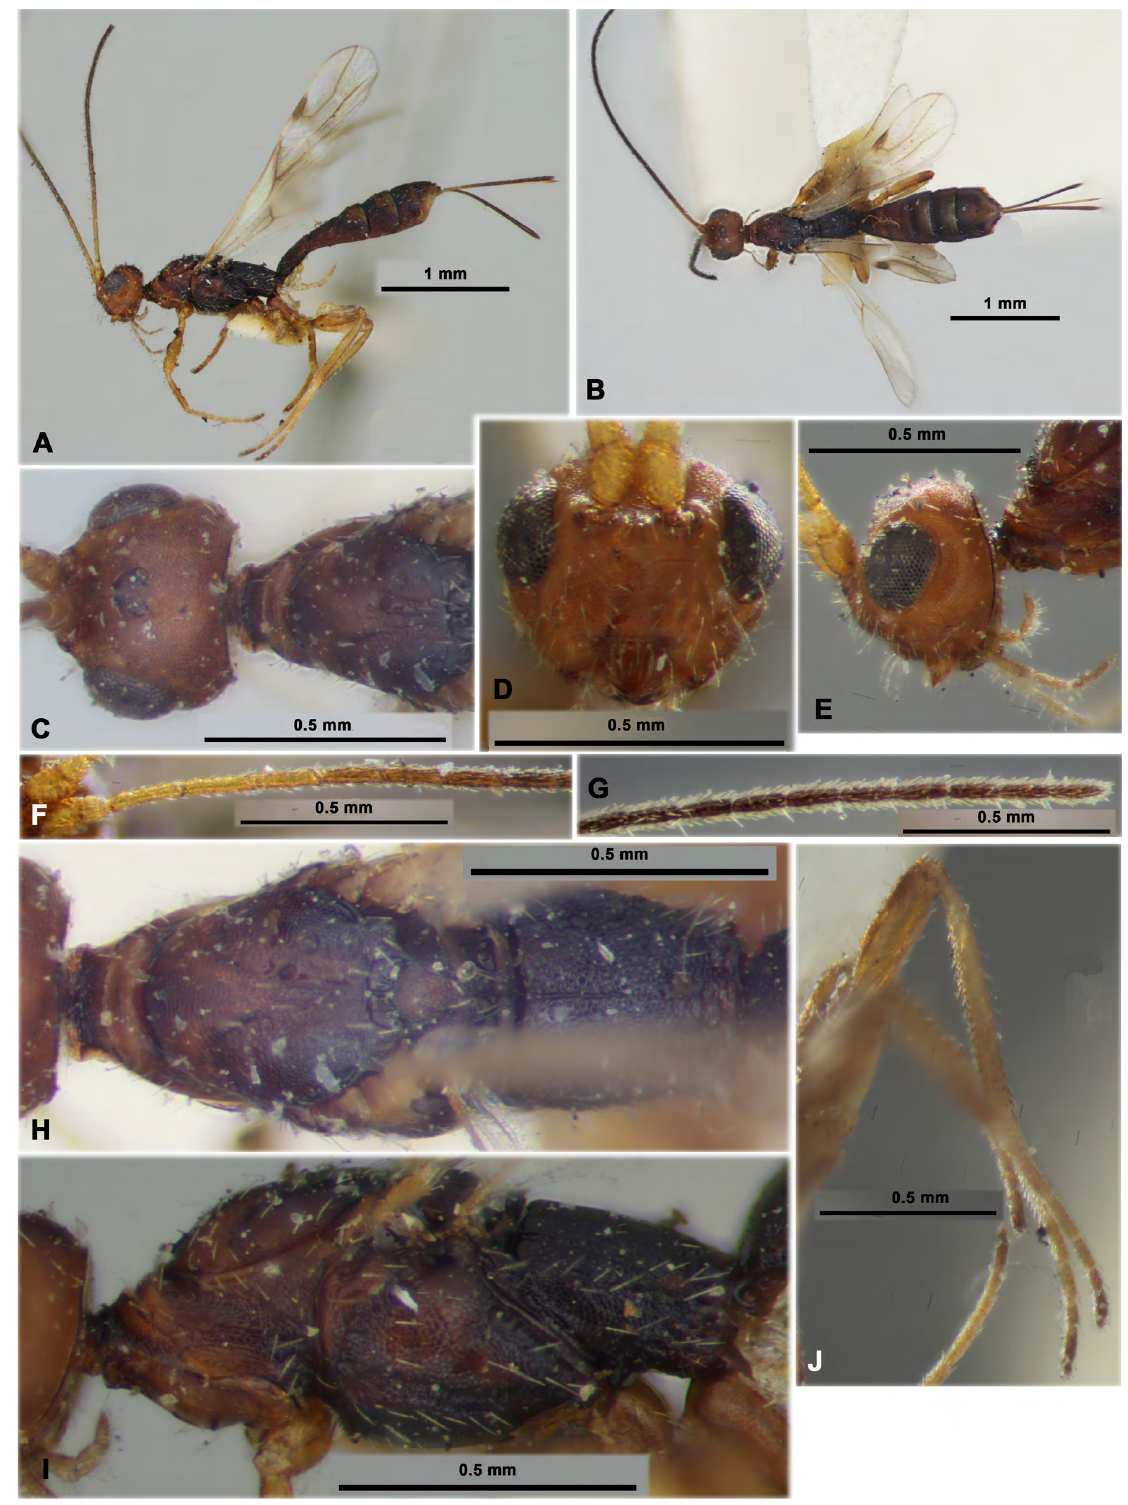
Fig. 44. Rhaconotus ( Rhaconotus ) aciculatus Ruthe, 1854, ♀, holotype, BMNH. A . Habitus, lateral view. B . Habitus, dorsal view. C . Head and mesoscutum, dorsal view. D . Head, front view. E . Head, lateral view. F . Basal segments of antenna. G . Apical segments of antenna. H . Mesosoma, dorsal view. I . Mesosoma, lateral view. J . Hind